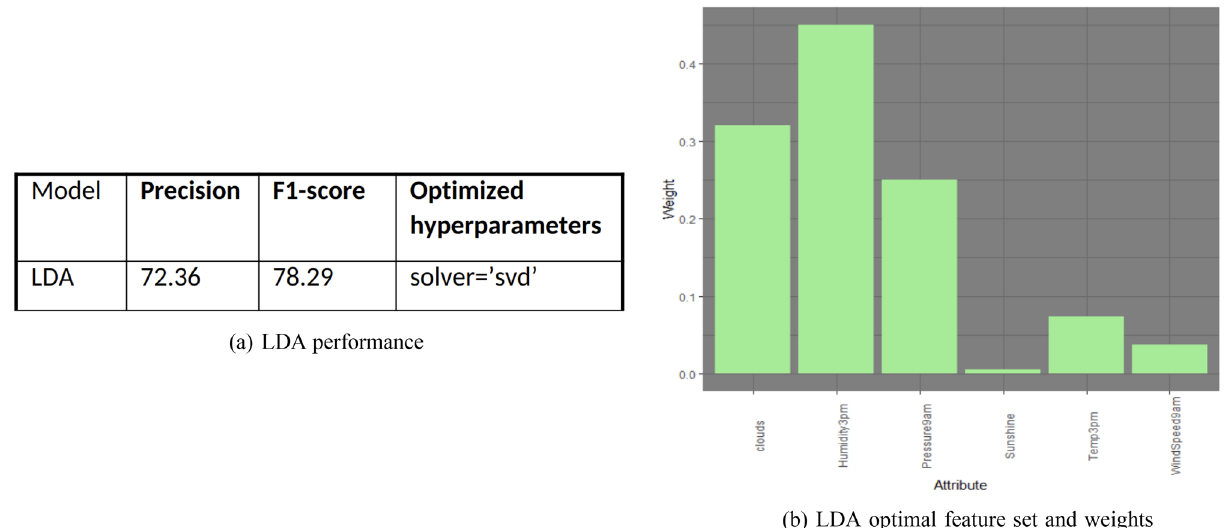
Figure 11. LDA performance and feature set.